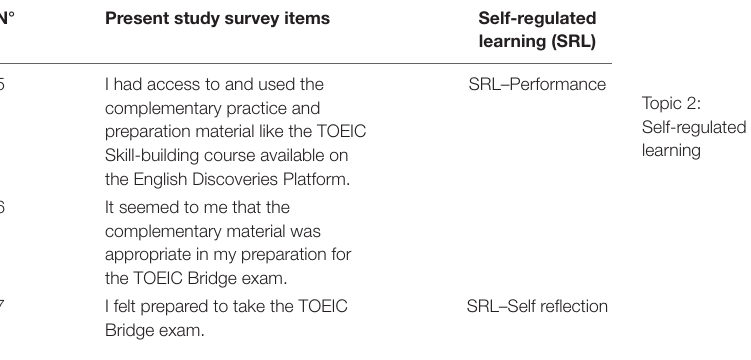
TABLE 2 | Survey alignment and self-regulated